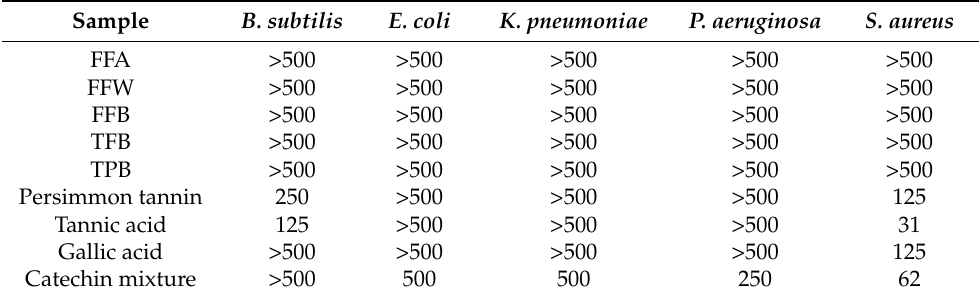
Table 6. Antimicrobial effectiveness